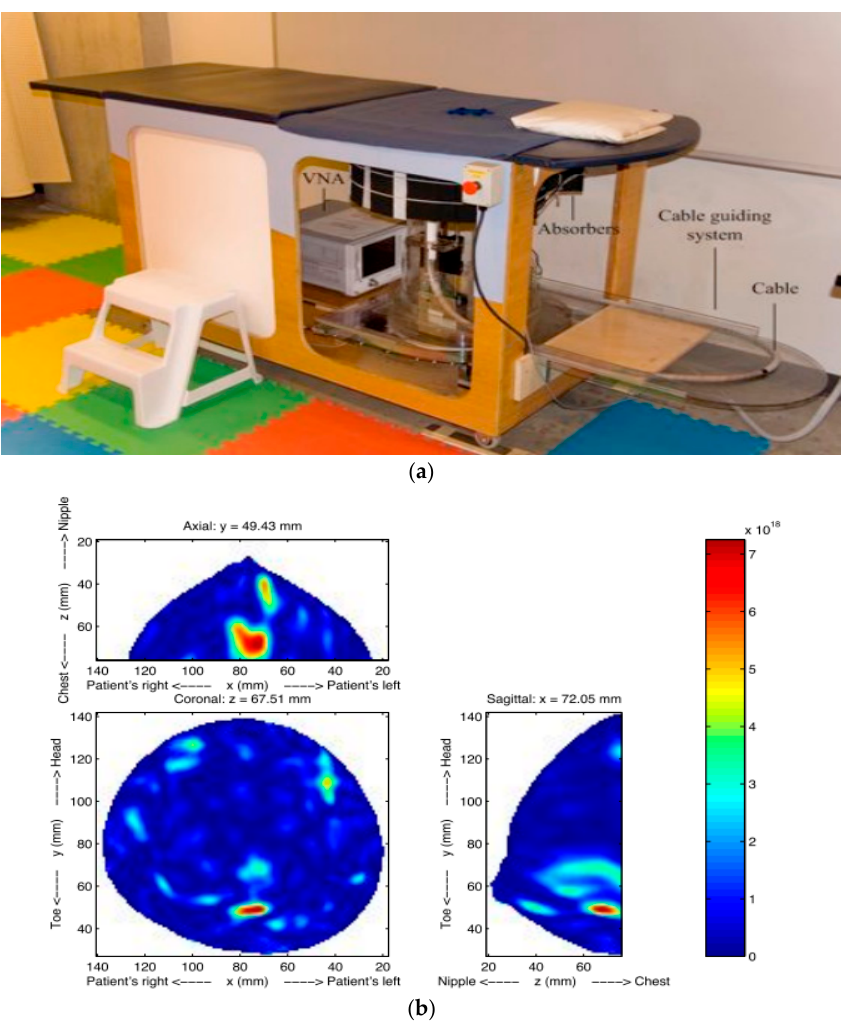
Figure 3. ( a ) TSAR prototype; ( b ) TSAR images from a patient.